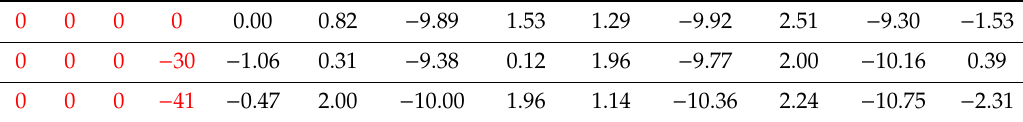
Table 1. Relative values of the sensors. Figure 8. 3D animation data flowchart.